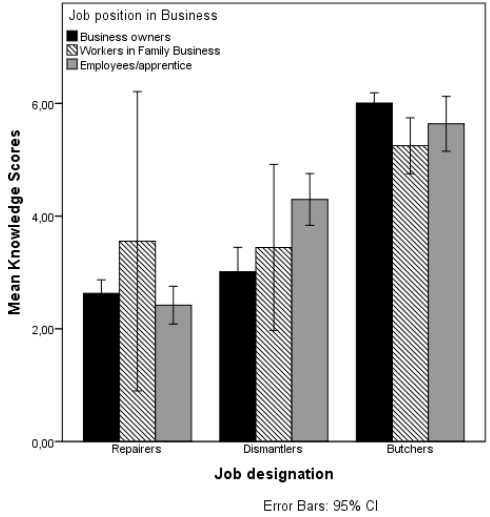
Figure 4. Mean knowledge score by job designation and job position in business.